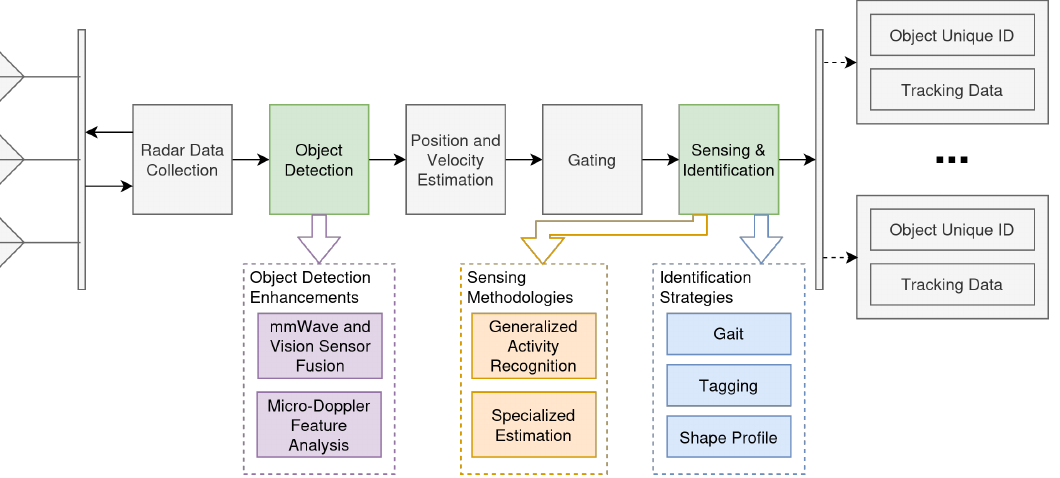
Figure 6. Areas explored and discussed in Section 3 in contrast to the typical multi-object mmWave tracking architecture block diagram presented in Figure